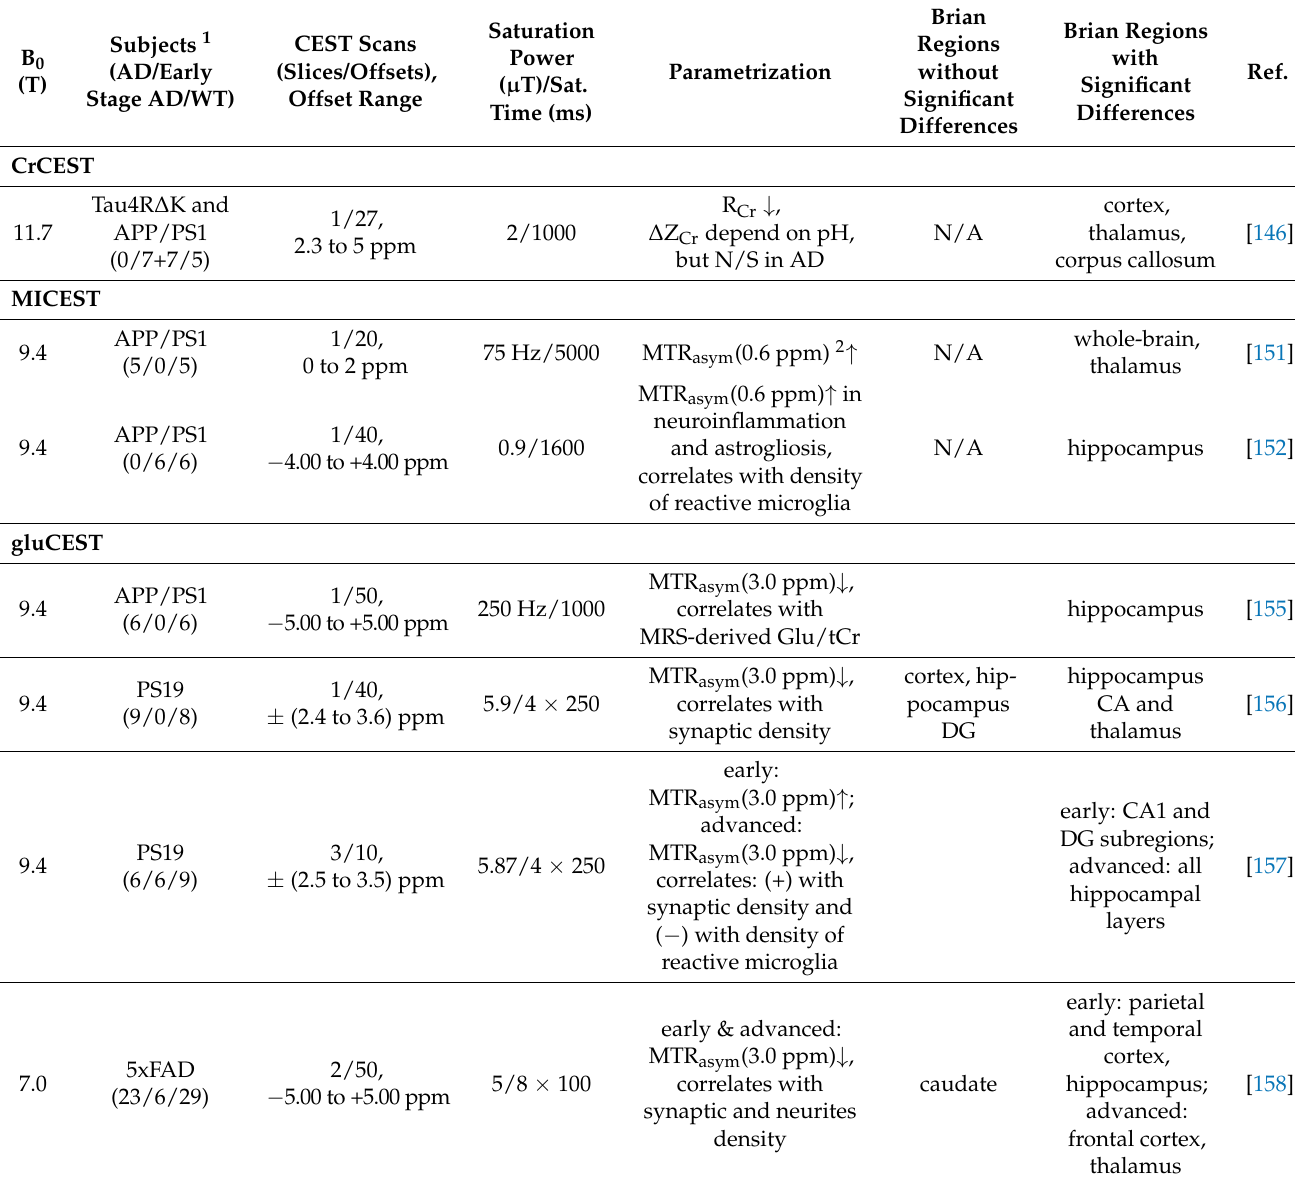
Table 5. Technical details of animal studies performed with the use of CrCEST, MICEST, and gluCEST